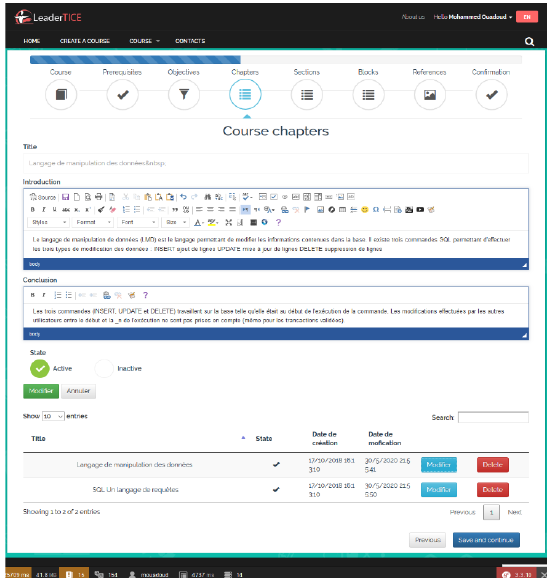
Fig. 6. Course chapters interface developed by the NoSQL MongoDB database and the Symfony framework